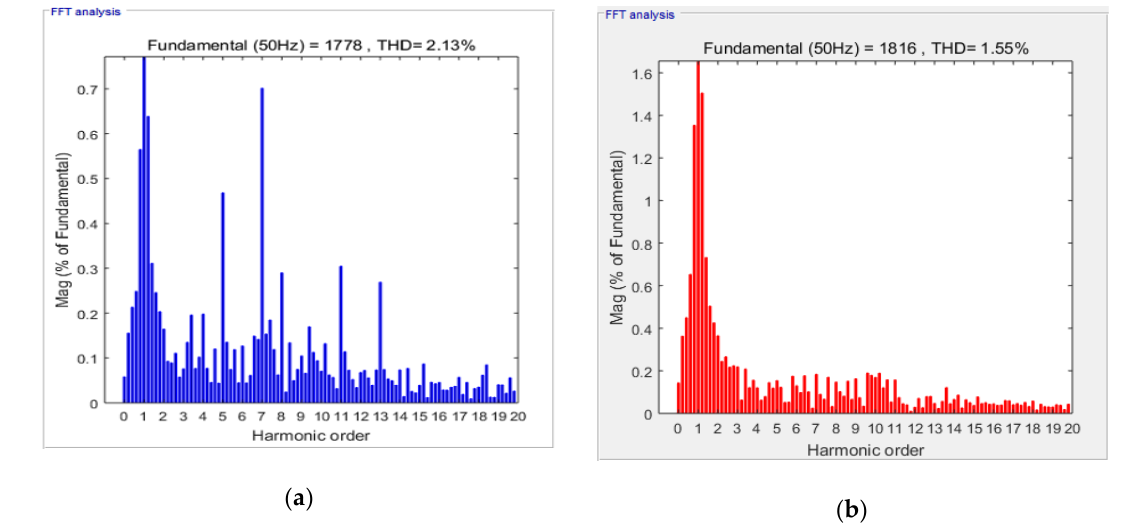
Figure 9. Comparison of harmonic content of grid-connected current in two control modes. ( a ) harmonic analysis under traditional control mode; ( b ) harmonic analysis under second-order LADRC control